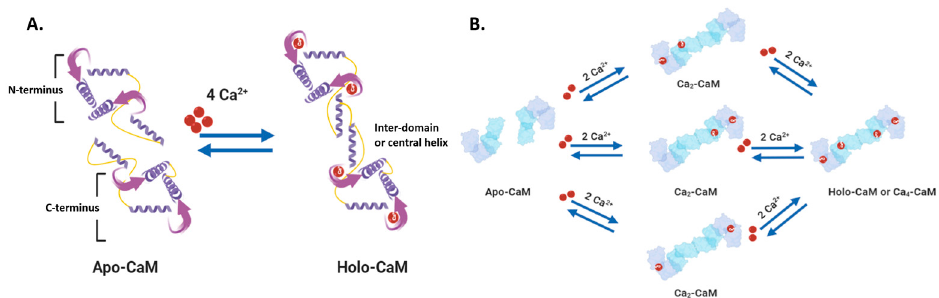
Figure 2. Overview of calmodulin structure and Ca 2+ binding conformations. ( A ) Calmodulin (CaM) structure comprises four EF-hand structures, two each on N- and C-termini that are connected via an inter-domain helix [6]. CaM exists either as Apo-CaM (no Ca 2+ bound to EF-hands) or Holo-CaM (Ca 4 -CaM or Ca 2+ ions bound to all EF-hands); ( B ) Different intermediate calmodulin conformations (Ca 2 -CaM) between Apo-CaM and Holo-CaM with Ca 2+ ions binding to two EF-hands during each step [8].